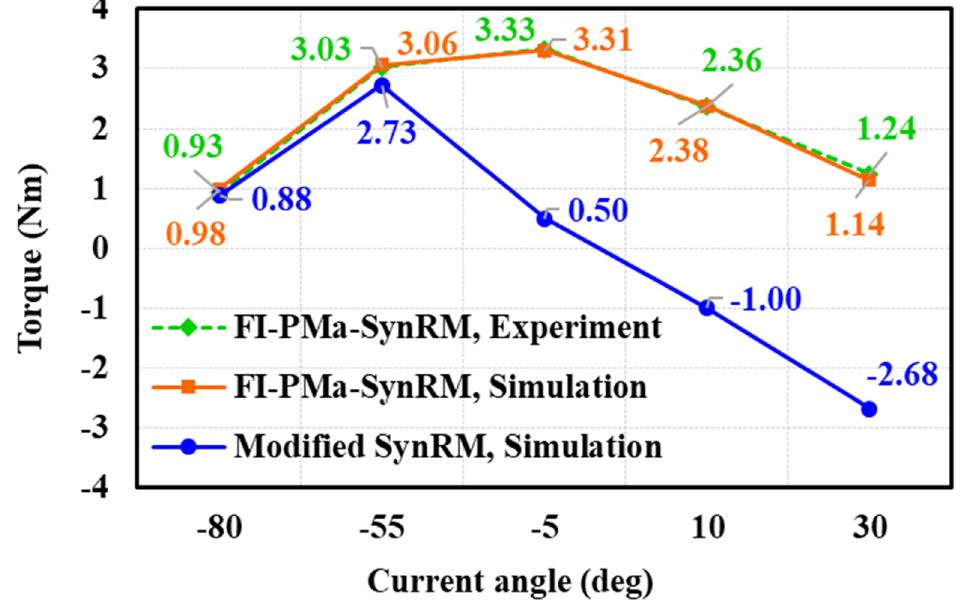
Figure 14. Current harmonics of developed FI-PMa-SynRM.